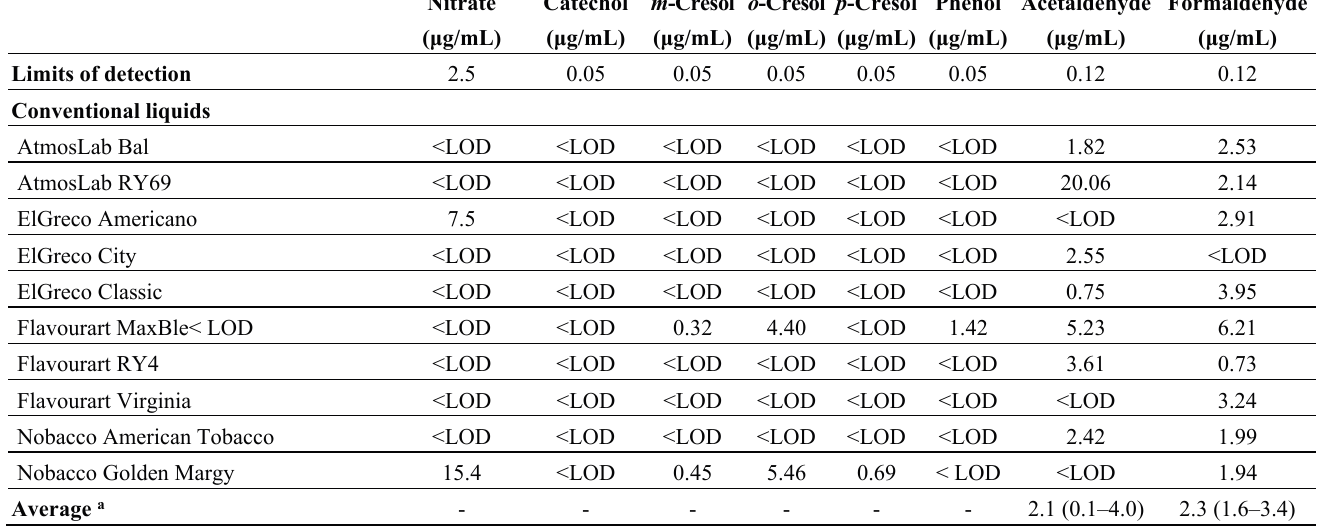
Table 2. Level of nitrates, phenols and aldehydes in electronic cigarette liquids produced with conventional flavours or natural extracts of tobacco (NET). Hydroquinone and resorcinol were not detected in any of the